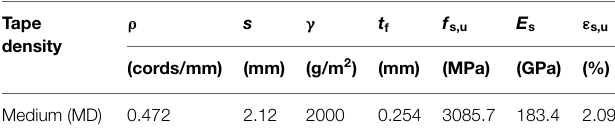
TABLE 1 | Properties of medium density dry steel